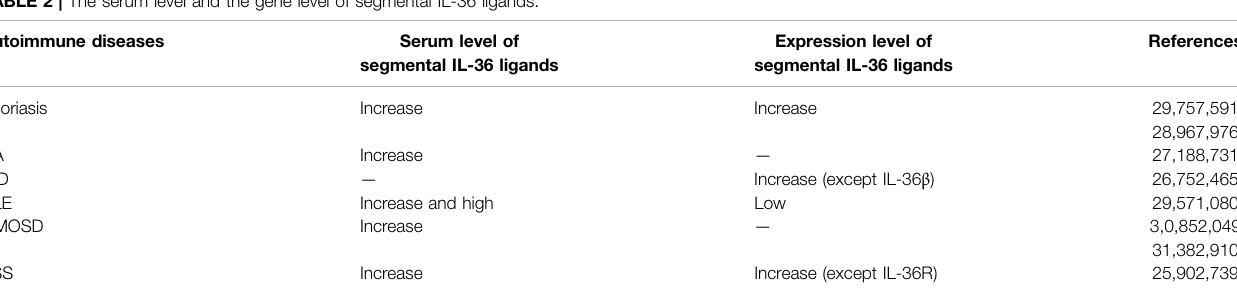
TABLE 2 | The serum level and the gene level of segmental IL-36